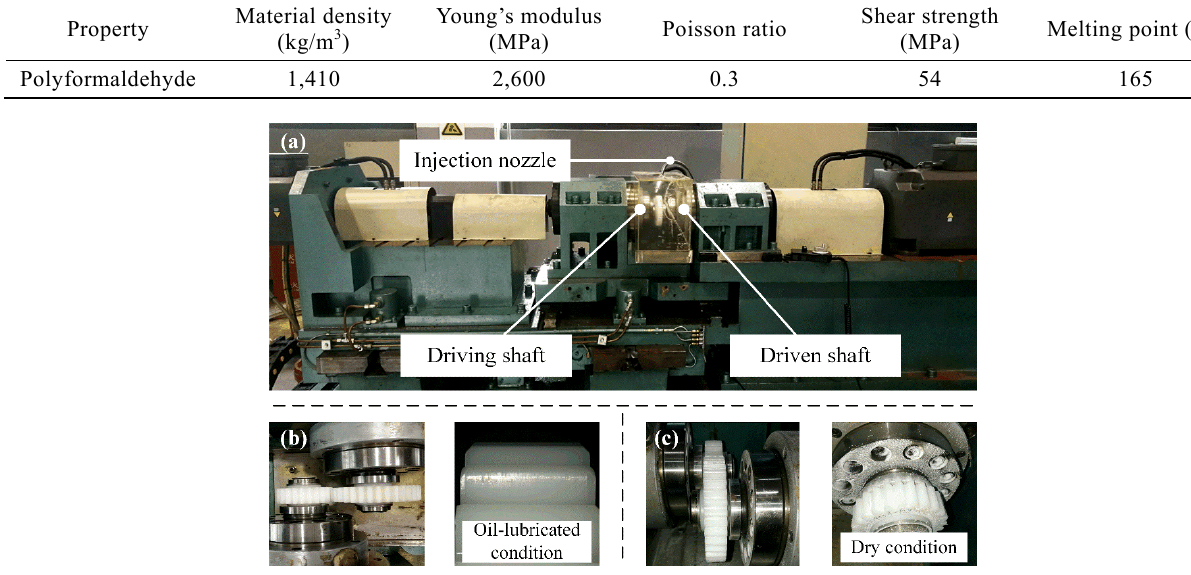
Table 2 Basic material properties of polyformaldehyde (Duracon, M90-44).